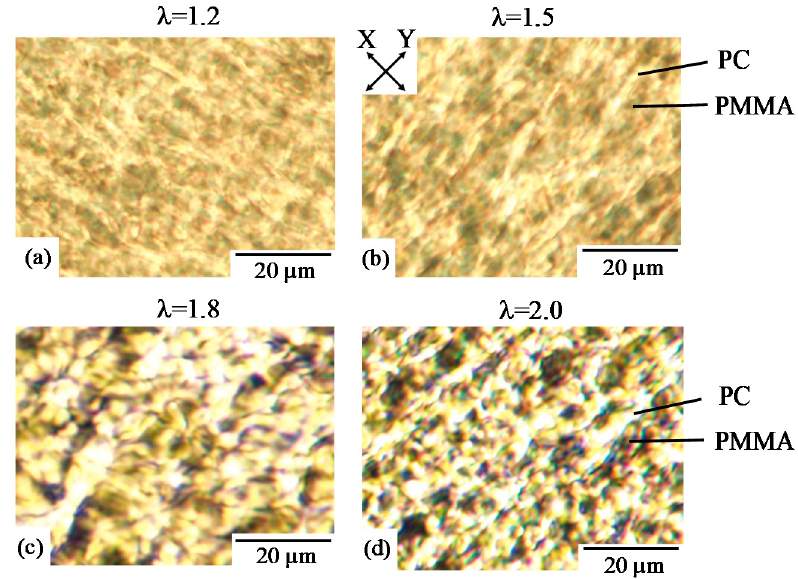
Figure 6. Unpolarized optical micrographs of 70/30 PC/PMMA obtained by simultaneous biaxial stretching at various draw ratios λ . ( a ) λ = 1.2; ( b ) λ = 1.5; ( c ) λ = 1.8; ( d ) λ = 2.0.